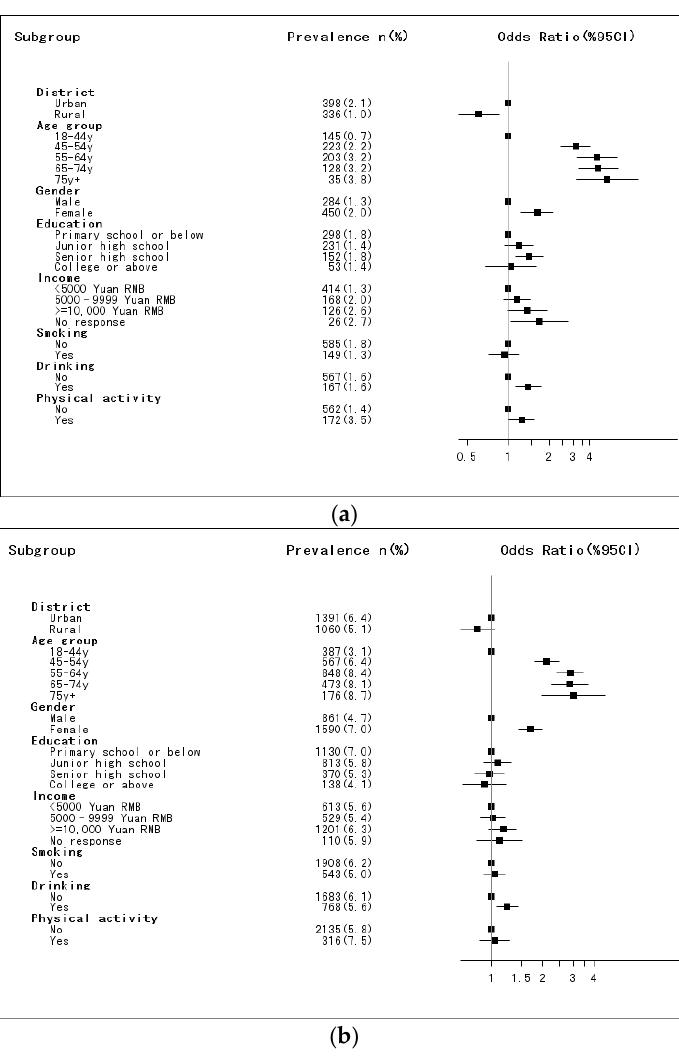
Figure 1. Association between socio-demographic factors or lifestyle and hypercholesterolemia in both surveys *; *: Models were adjusted for the variables in the figure. ( a ) Survey 2002; ( b ) Survey 2010–2012.